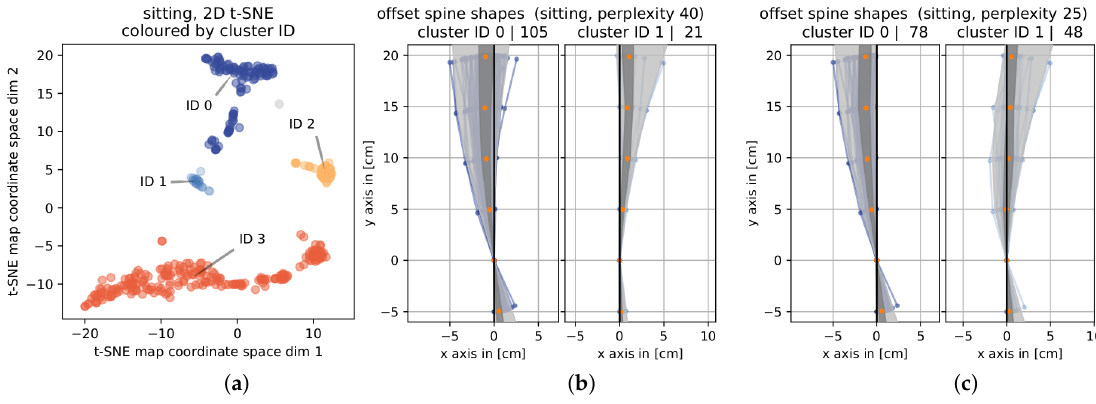
Figure 6. Visual comparison of changes in clustering when varying perplexity. ( a ) A 2D t-SNE map and ( b ) offset spine shape bundles per cluster for a perplexity value of 40. ( c ) offset spine shape bundles per cluster for a perplexity value of 25. The offset spine shape bundles displayed represent the only two clusters that changed for a perplexity value of 40. All axis titles of the offset spine shape bundles contain information of the cluster ID and the number of elements in that